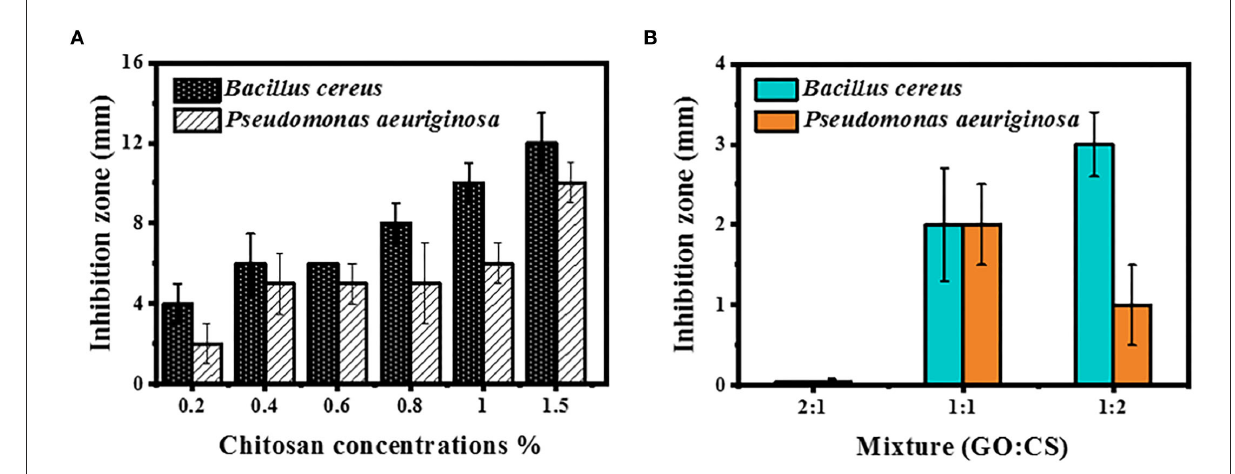
FIGURE3 Inhibition zone measurement by BC and PAO1 at different concentrations of chitosan (A) and different ratios of GO:CS composite (B) .